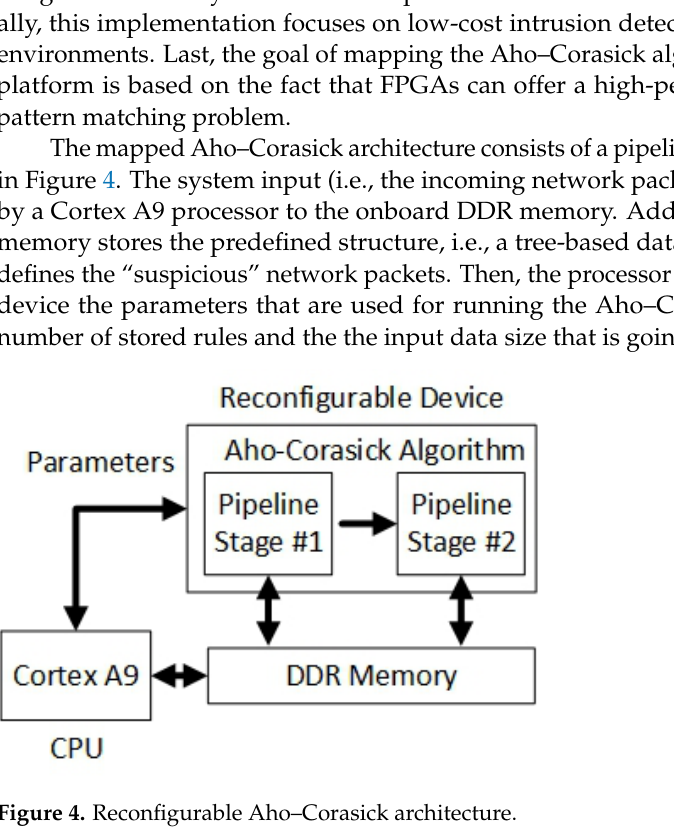
Figure 4. Reconfigurable Aho–Corasick